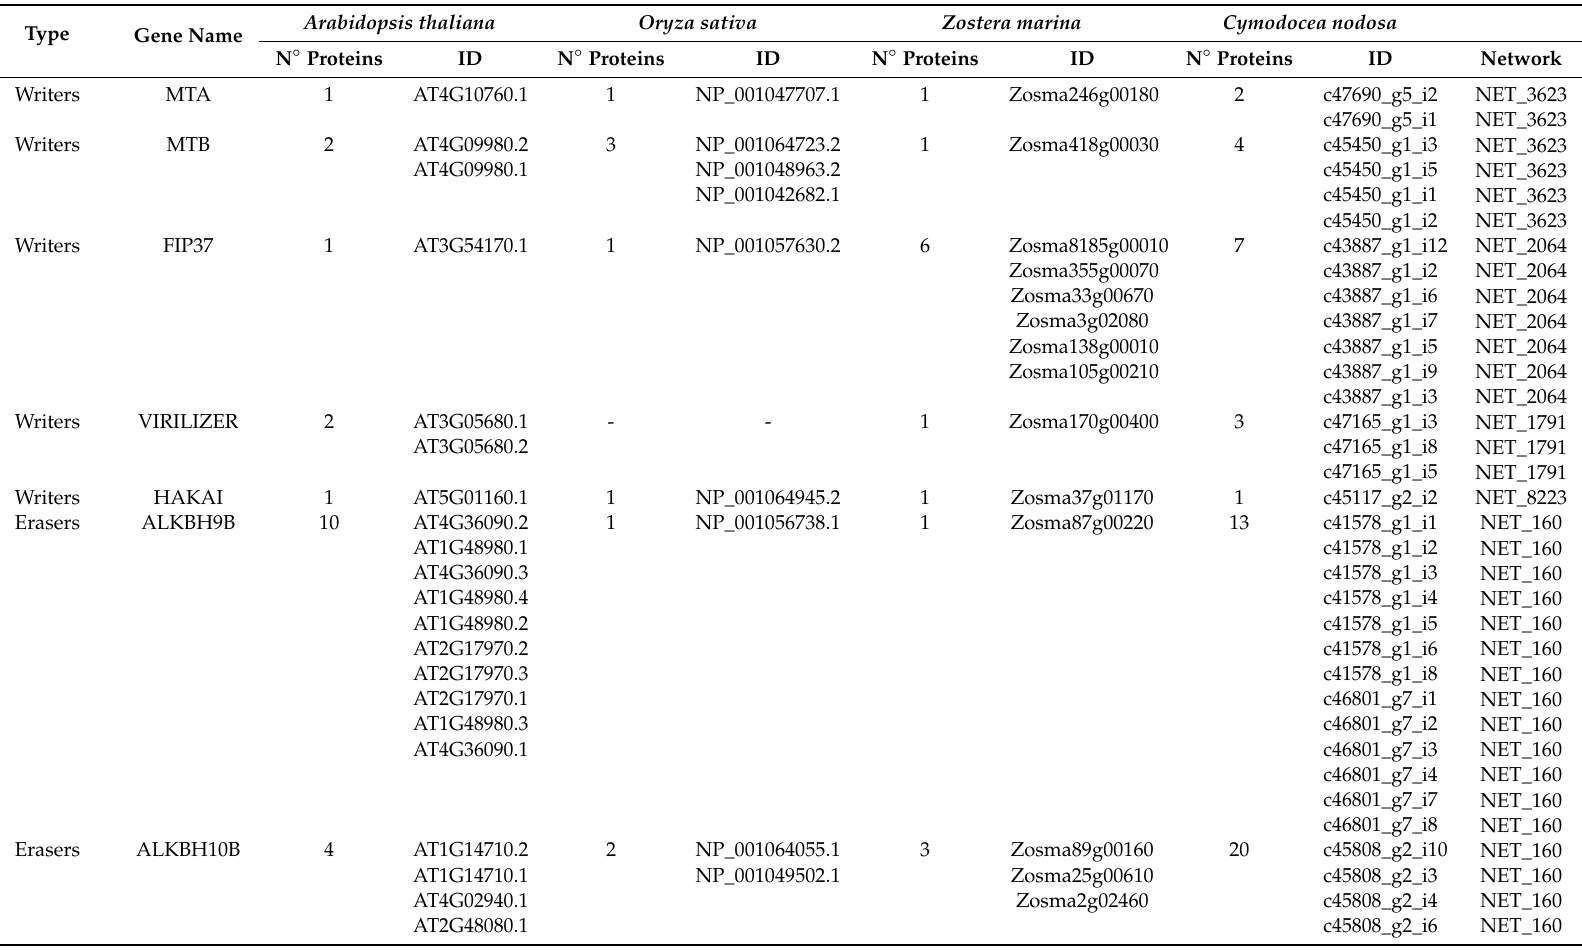
Table 1. List of writers and erasers involved in RNA methylation (m 6 A) in terrestrial model plants ( A. thaliana and O. sativa ) and their orthologs in the seagrass Z. marina and C. nodosa , as resulting from the gene-network analysis. The ID refers to transcripts in Arabidopsis , Zostera and Cymodocea , or to proteins in Oryza .